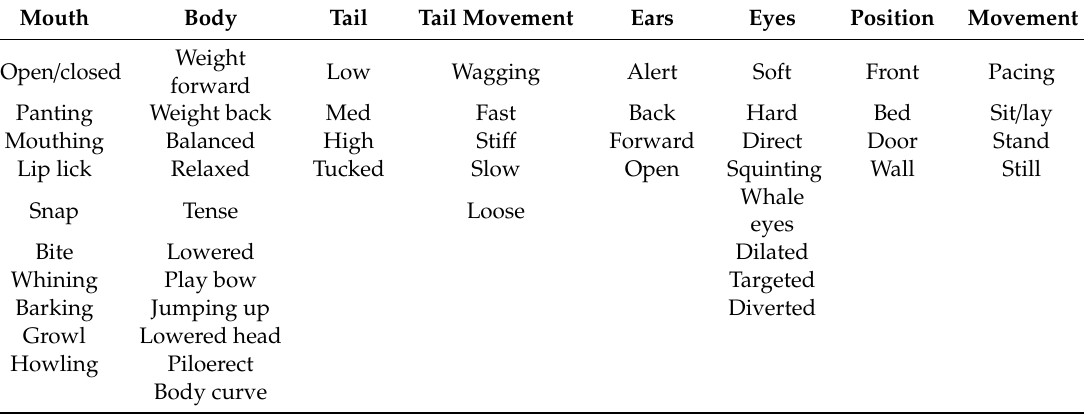
Table 1. Behaviours of dogs (n = 107) recorded for each body part, as well as the position in the room and movement